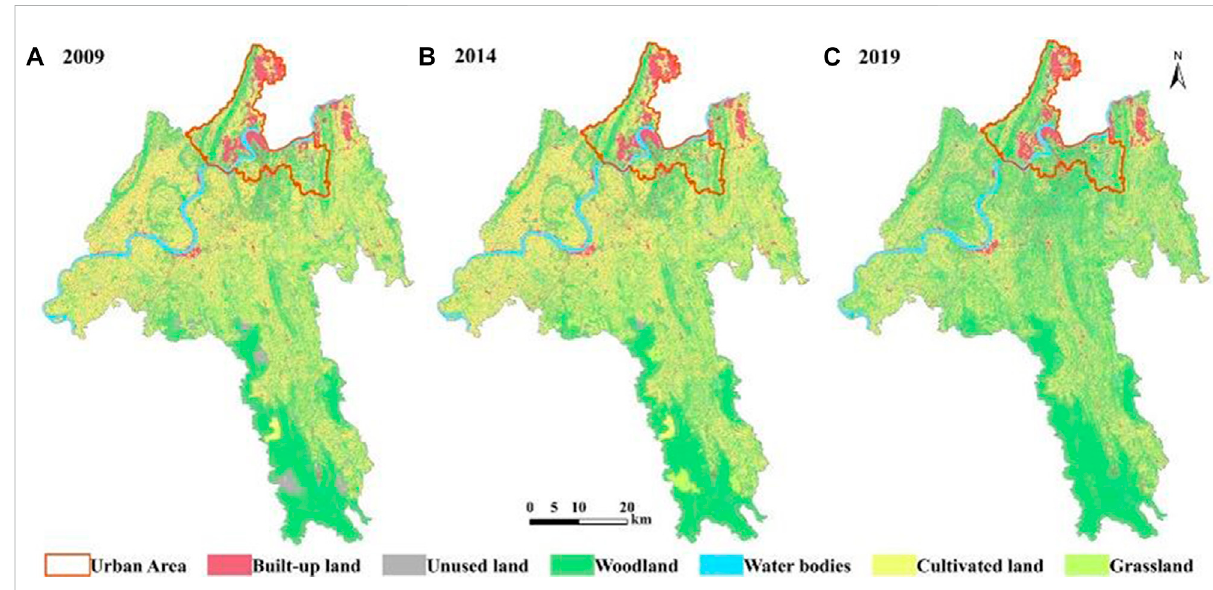
FIGURE 3 LanduseofJiangjinin2009,2014,and2019. (A) :DistributionoflandusetypesinJiangjinin2009; (B) :DistributionoflandusetypesinJiangjinin 2014; (C) : Distribution of land use types in Jiangjin in